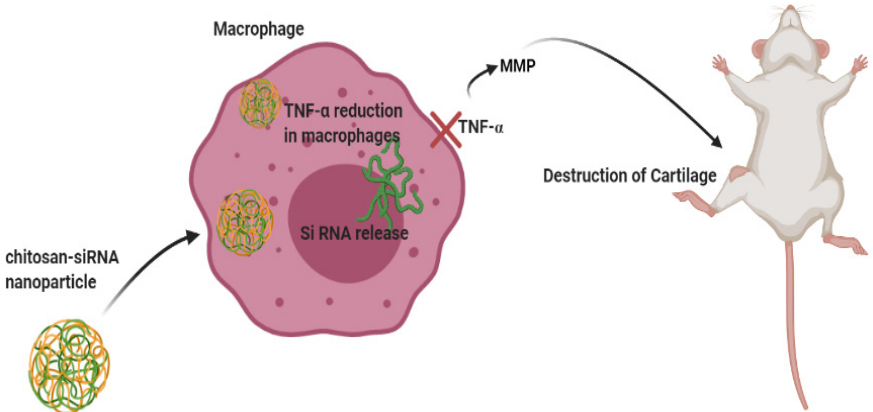
Figure 3. CS-siRNA NP delivery in macrophages to suppress TNF- α expression. Macrophage elimination by CS-siRNA NPs was established to inhibit a local production of IL-1 β , IL-6, TNF- α , and matrix metalloproteinases (MMPs) and thus reduce the pathogenesis of inflammatory arthritis.